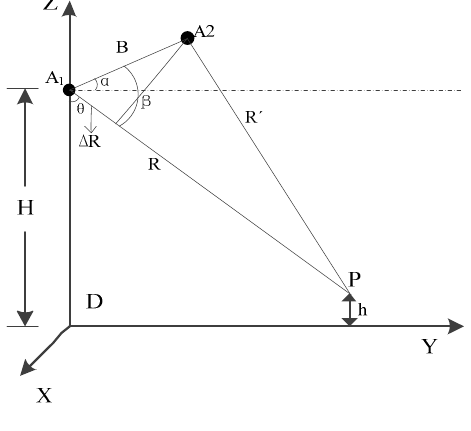
Figure 1. Repeat-pass work mode.